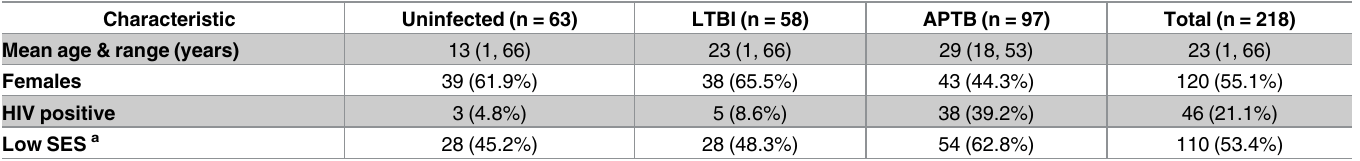
Table 1. Study participant